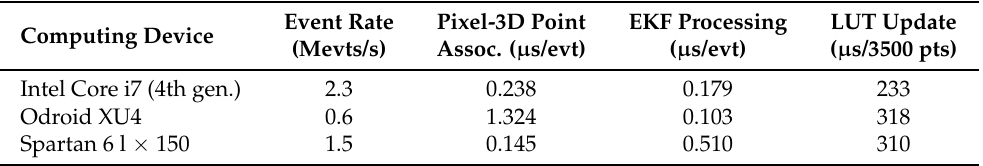
Table 1. Average events throughput and processing time for the different functions. Computing